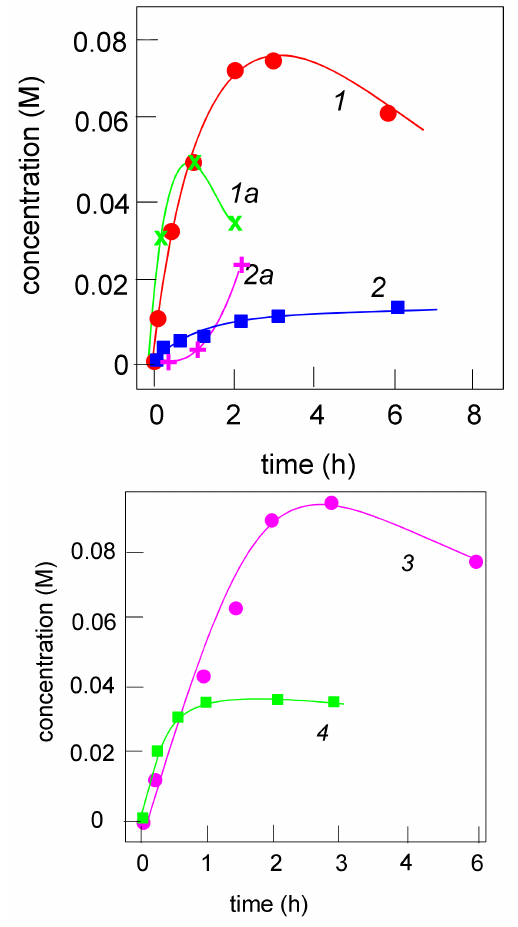
Figure 10. Oxidation of cyclohexane (0.46 M) with hydrogen peroxide (50% aqueous; 2.0 M) catalyzed by complex 2 (concentration 5 × 10 − 4 M) in the presence of nitric acid (0.05 M) in acetonitrile at 50 ◦ C. Concentrations of cyclohexanol (curve 1 ), cyclohexanone (curve 2 ), and sum cyclohexanol + cyclohexanone (curve 3 ) were determined after the reduction of the aliquots with solid PPh 3 . Concentrations of cyclohexanol (curve 1a ) and cyclohexanone (curve 2a ) in the absence of nitric acid in the analogous experiment. For the comparison, the accumulation of cyclohexanol + cyclohexanone in the oxidation of cyclohexane with tert -BuOOH under the same conditions is represented by curve 4